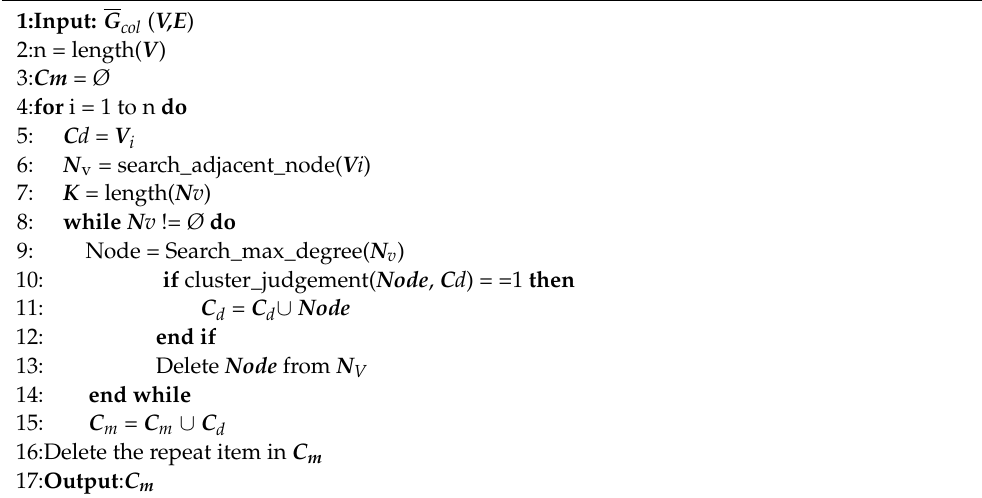
Algorithm 2 Cluster Searching Algorithm for Conflict